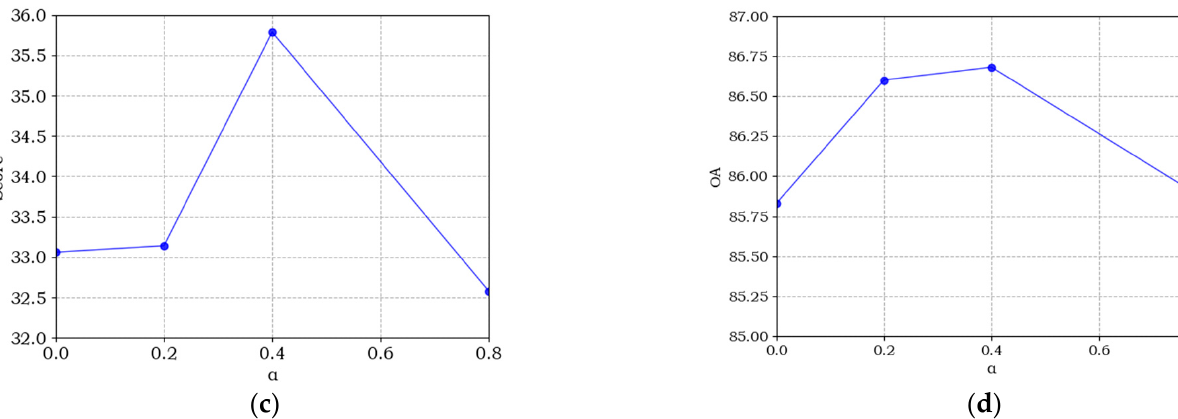
Figure 10. Sensitive analysis of α for the multi-task loss. ( a – d ) denote the accuracy curve of mIoU, Sek, Score, and OA, respectively.